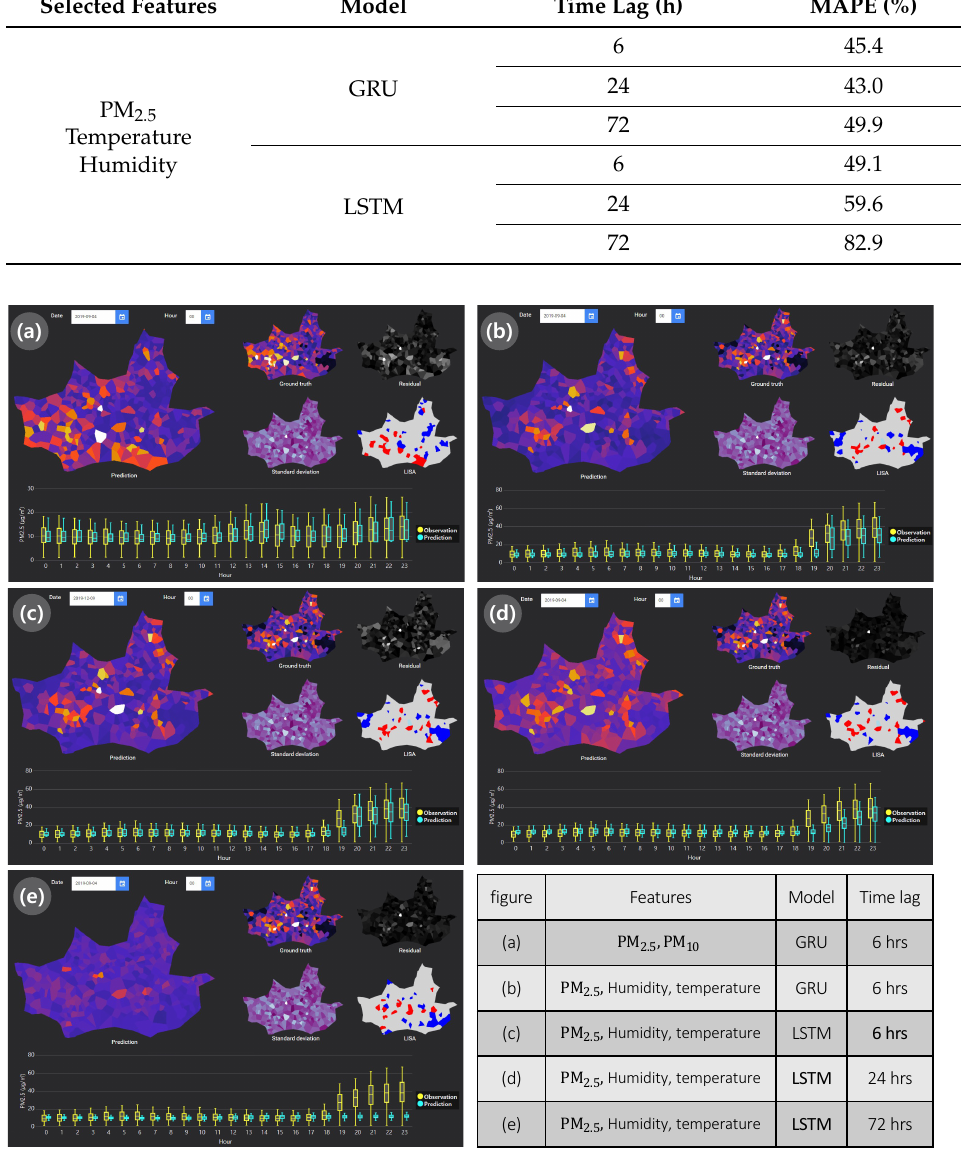
Figure 3. The visualizations of PM 2.5 predictions. ( a , b ) Visualizations of prediction results with different features. ( c – e ) Results with different time